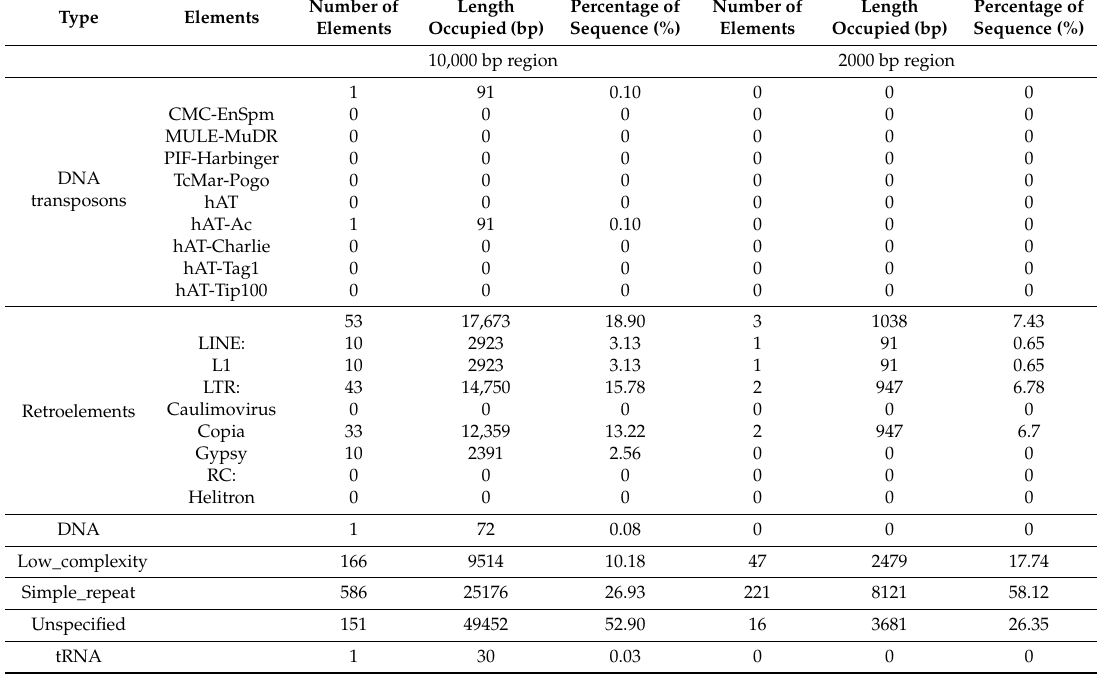
Table 2. Transposable elements in the vicinity of the NF-YB gene